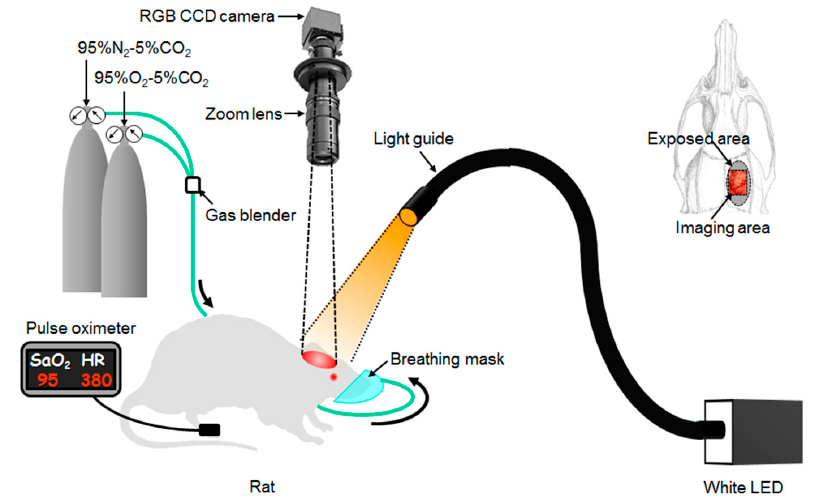
Figure 7. Schematic diagram of the experimental system and representation of the rat skull with a color photograph of the exposed rat brain. Red-green-blue (RGB); light-emitted diode (LED); heart rate